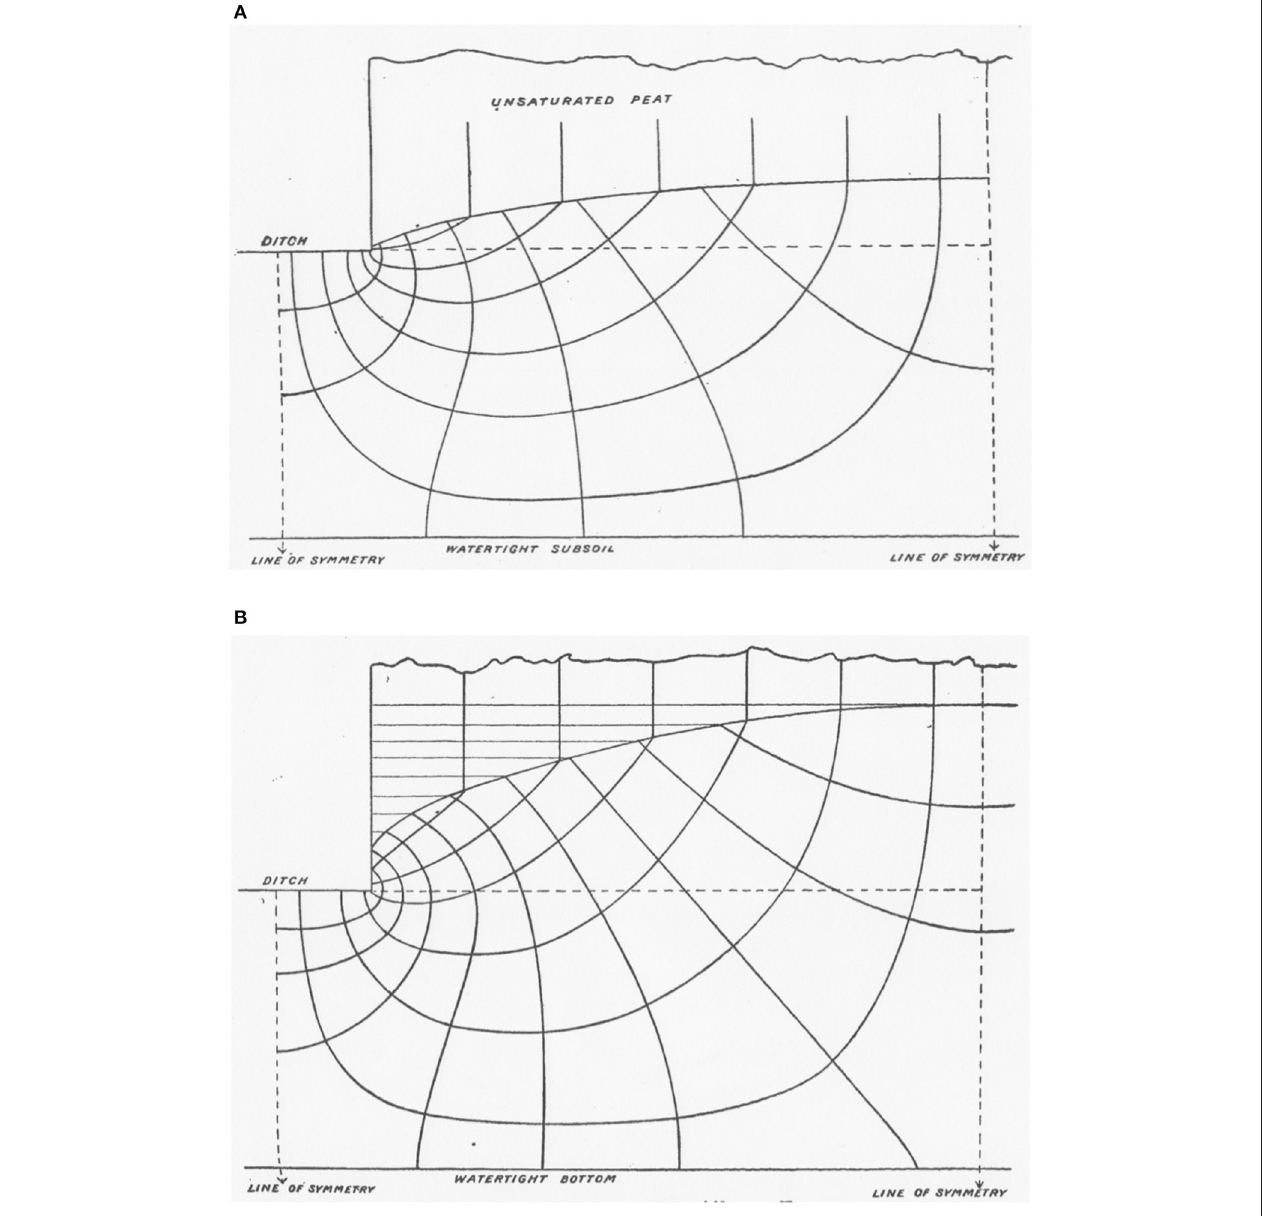
FIGURE 5 | Flow nets (A) for flow to ditch with W / ( Kg ρ ) = 0.068, (B) for flow to drain with W / ( Kg ρ ) = 0.226. Parts (A,B) copied, respectively, from Figures 5, 6 in Richardson (1908b), with permission from the Royal Dublin Society